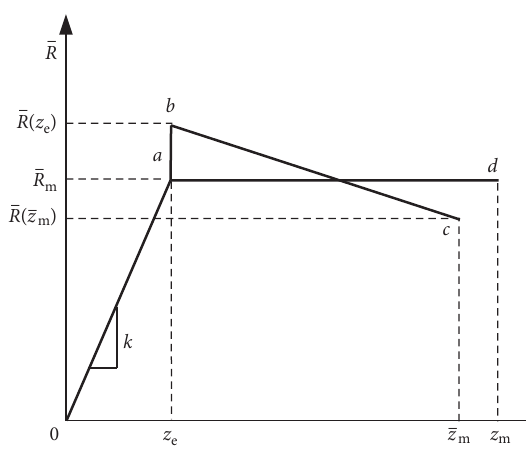
Figure 8: Resistance function model considering axial force.